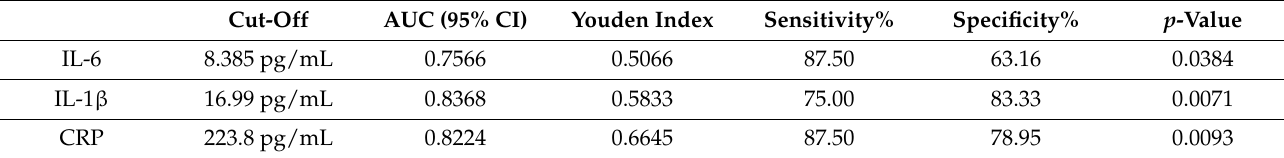
Table 3. ROC logistic regression analysis of salivary IL-6, IL-1 β , and CRP as potential diagnostic biomarkers to differentiate children with a moderate degree of PIG from children with a severe degree of